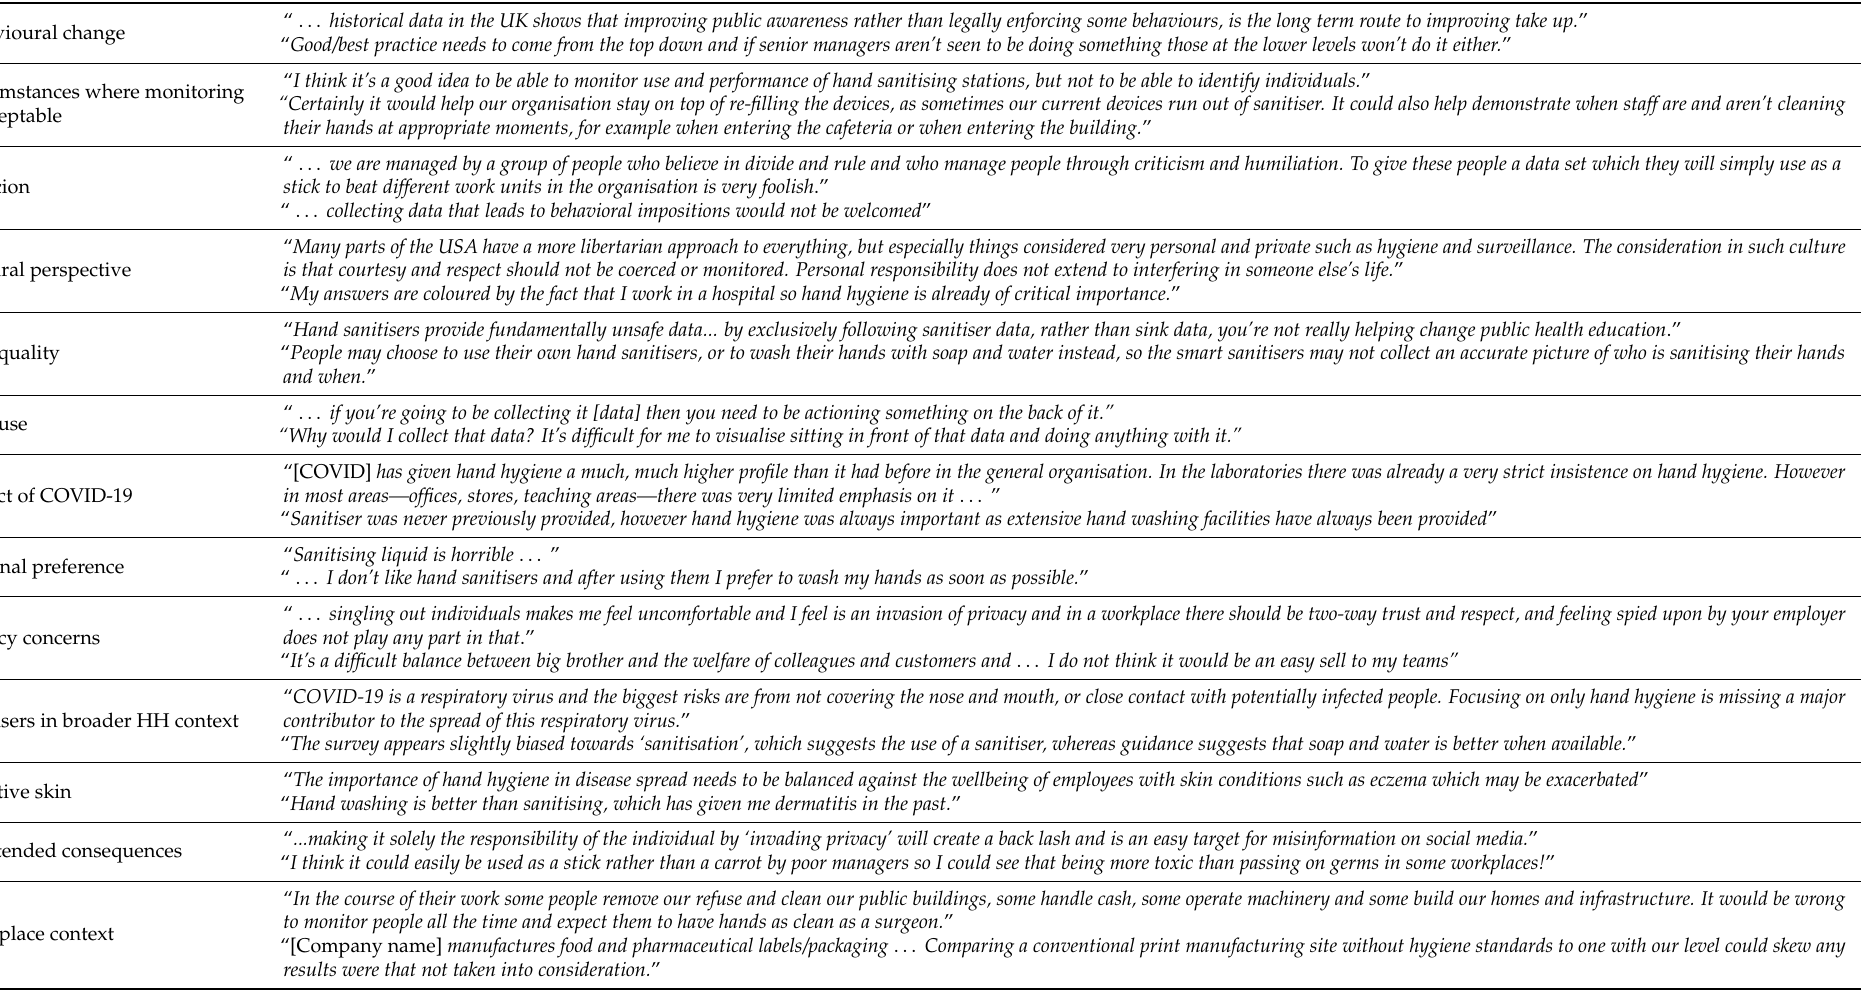
Table 8. Themes identified from qualitative